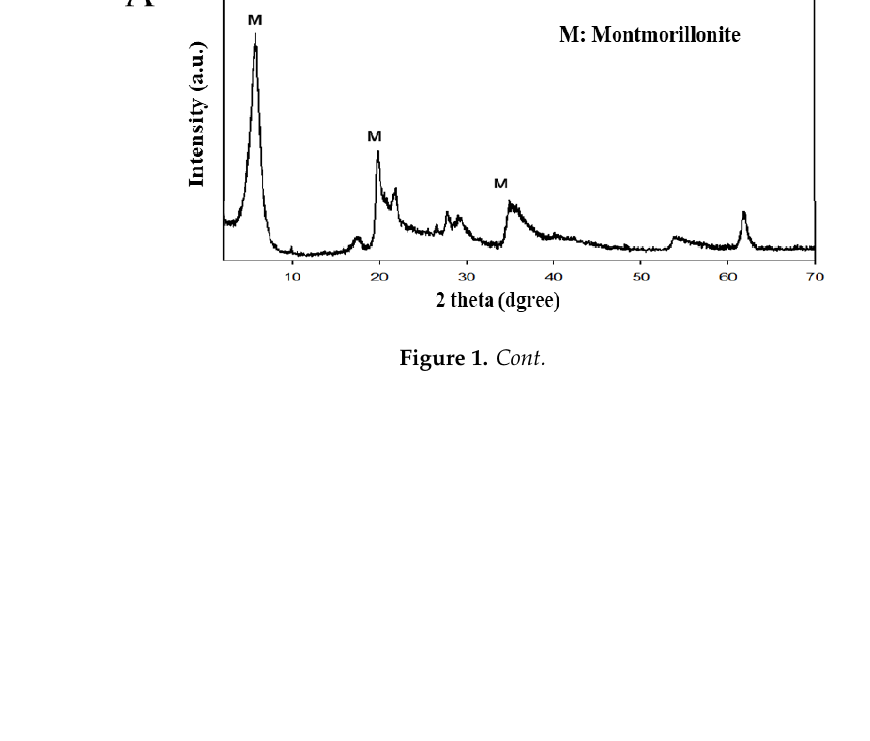
Figure 1. ( A ) X-ray powder diffraction (XRD) pattern, ( B ) scanning electron microscopy (SEM) image (magnified 15.58K-fold), ( C ) energy-dispersive X-ray spectroscopy (EDS) spectrum of purified montmorillonite, and ( D ) particle-size distribution of the nano-montmorillonite suspension. 3.2. NM Activates Alp and Mineralization in Osteoblasts